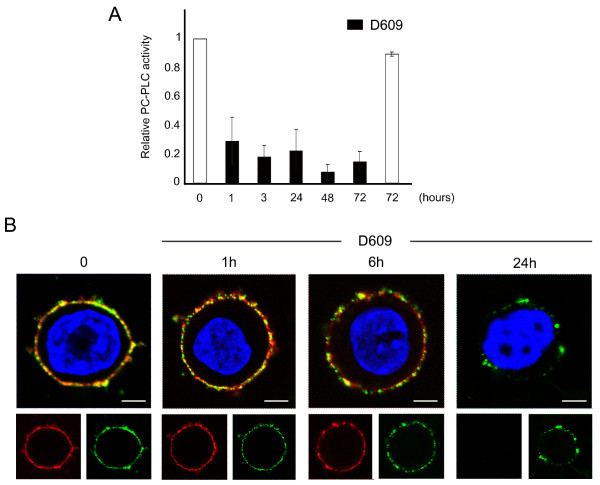
D609-induced PC-PLC inhibition and HER2 downmodulation in SKBr3 cells. (a) Amplex Red® assay SKBr3 cells after exposure to the PC-PLC inhibitor D609. Relative PC-PLC activity was measured in the presence of D609 (50 μg/mL, black columns) and compared with that of untreated control cells (t = 0 taken as 1.0 or t = 72 hours, white columns). Histograms represent the mean ± SD (n = 4). (b) CLSM analyses of unfixed SKBr3 cells cultured in complete medium (t = 0) and in presence of D609 for the indicated time periods. After washing, cells were stained with α-PC-PLC (green) and α-HER2 (red). Nuclei were stained with DAPI (blue). Colocalization areas are represented in yellow. Scale bars, 5 μm. These experiments were independently repeated 3 times.